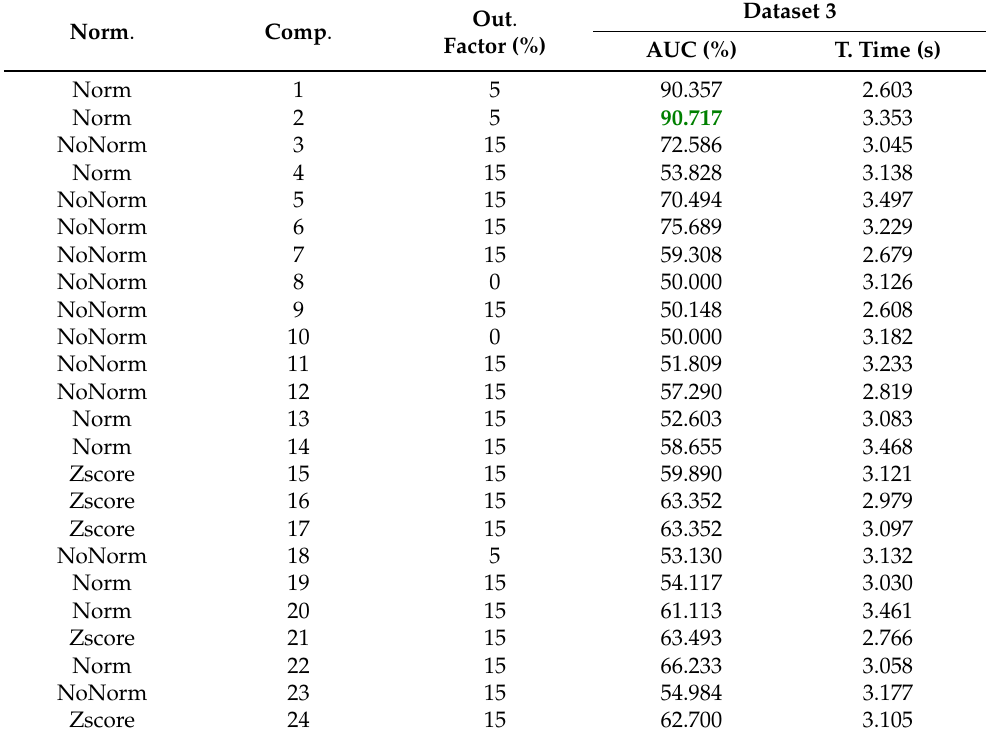
Table 5. PCA results for dataset